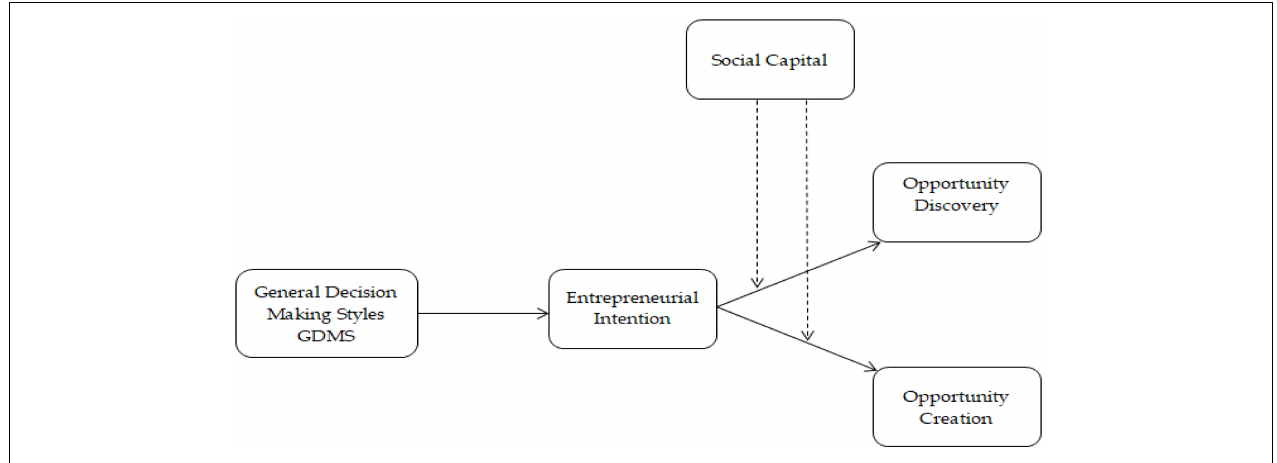
FIGURE 1 | Conceptual